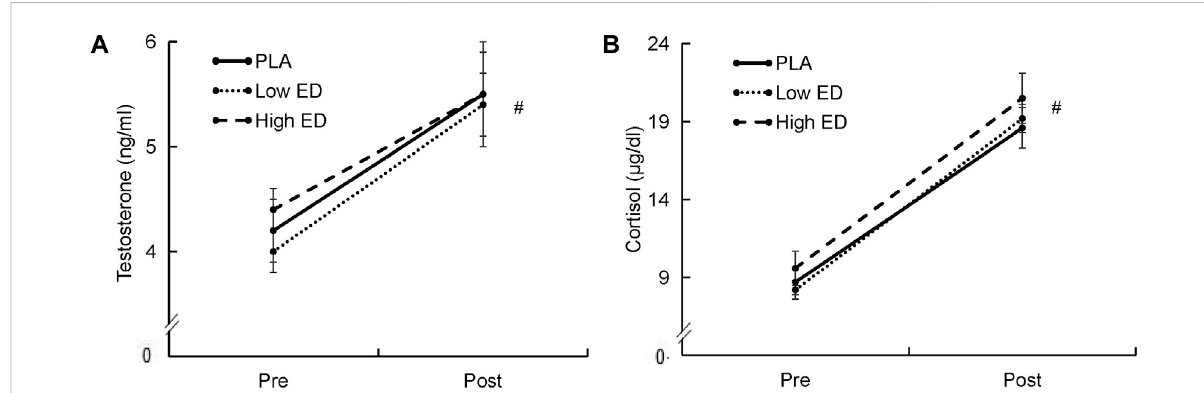
FIGURE 6 Serum testosterone (A) and cortisol (B) in triathlon with placebo (PLA), low-dosage energy drink (Low ED) group and high-dosage energy drink (High ED) group at baseline and immediately after sprint triathlon Values are expressed as mean ± SE. *Signi fi cant difference compare with pre and post ( p < 0.05) in PLA, Low ED and High ED group. Values are expressed as mean ± SE.